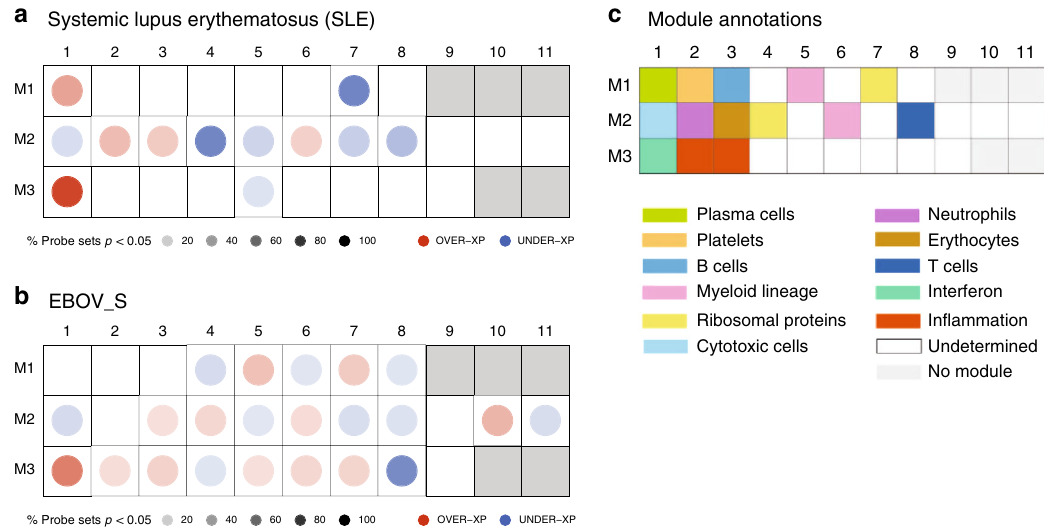
Fig. 6 Similarities between EBOV_S and SLE and acute EBOV immune signatures. Mapping global transcriptional changes with the use of Chaussabel ’ s modules 28 for which at least 15% of the transcripts are signi fi cantly changed between controls ( n = 12) and patients with SLE ( n = 22) ( a ) or HDs ( n = 33) and EBOV_S ( n = 26) ( p value <0.05 for the Mann – Whitney/Wilcoxon ’ s test) ( b ). Module annotations ( c ). Spots indicate the proportion of genes signi fi cantly changed for each module ( p value <0.05 for SLE as per Chaussabel et al. 28 , fold change >1.5, and FDR <0.05 for EBOV_S). Coordinates indicate module ID (e.g., M2.8 is row M2, column 8). Overexpressed modules are indicated in red and underexpressed modules are indicated in blue, in comparison to control groups. Functional interpretation is indicated on a grid by a color code 28